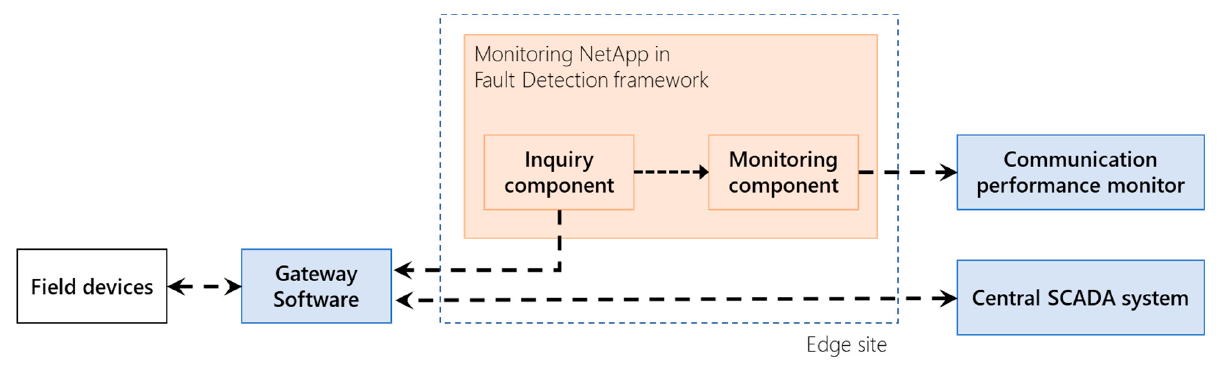
Figure 7. Software component architecture of the NetApp in UC1.